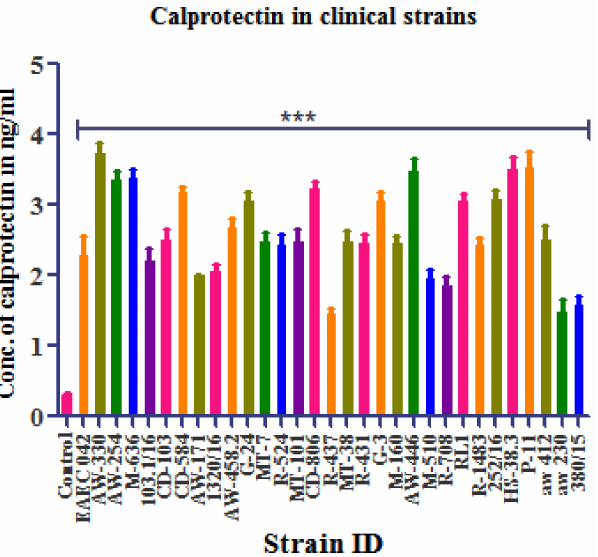
Figure 5. The concentration of calprotectin (ng/mL) in BALB/c mice infected with the EAEC strain of human origin. *** p , 0.001;comparison by one-way ANOVA with Dunnett’s multiple comparison tests. NS = non-significant.